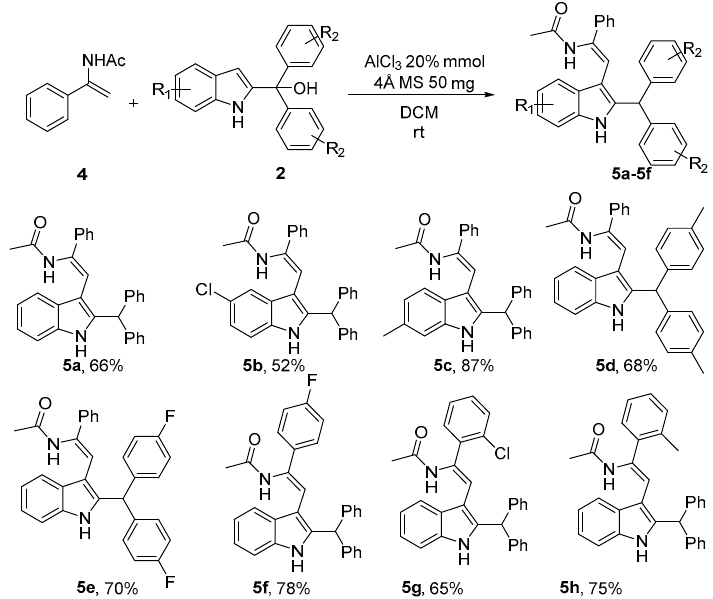
Figure 4. Scope of 2-indolemethanols with acyclic enamide 4.